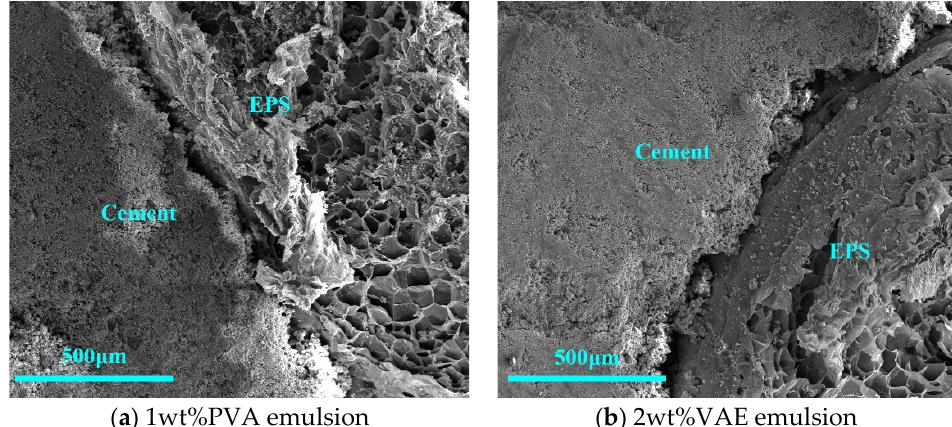
Figure 8. Microstructure of interface treated with the polymer binder.